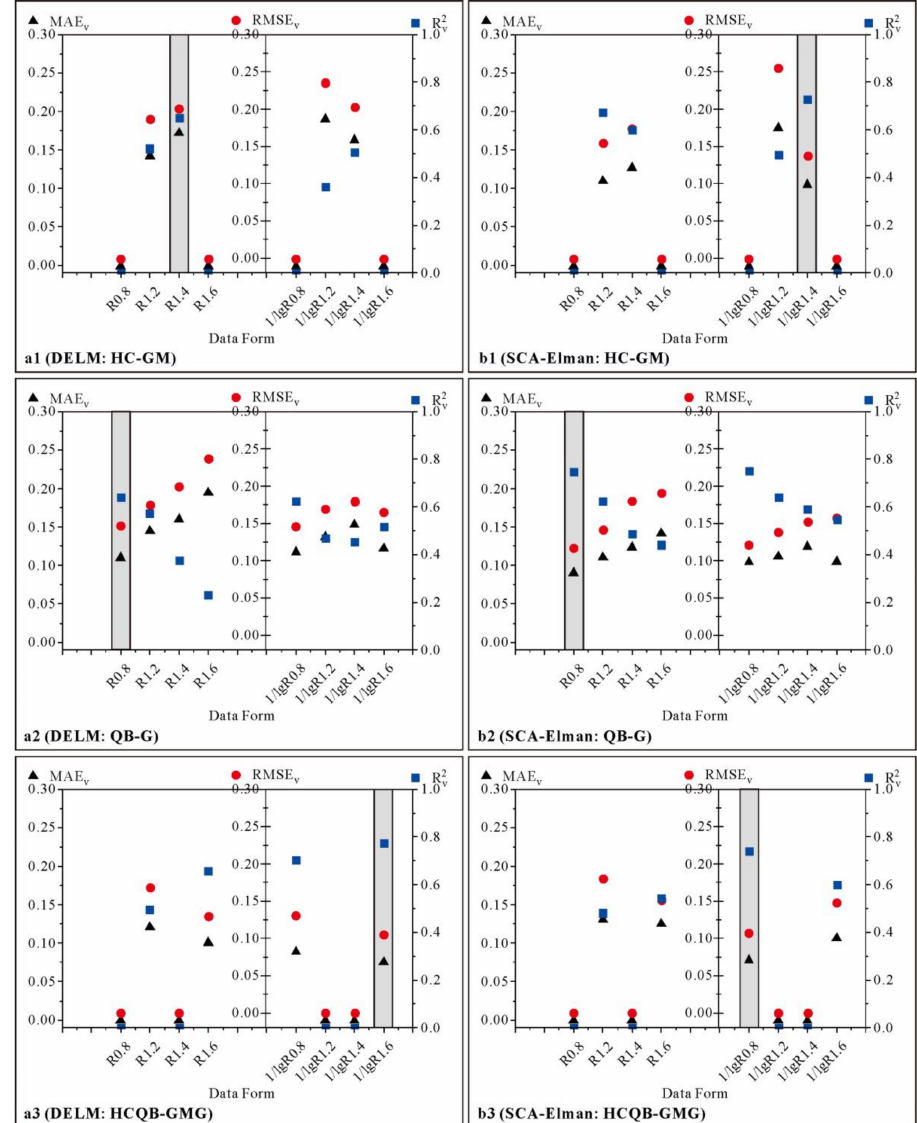
Figure 6. The modeling results of the validation dataset of the DELM for ( a1 ) HC–GM, ( a2 ) QB–G, and ( a3 ) HCQB–GMG and SCA–Elman for ( b1 ) HC–GM, ( b2 ) QB–G, and ( b3 ) HCQB–GMG with different data sources (the values of MAE and RMSE were processed with min–max normalization). The gray column indicates the optimal model’s